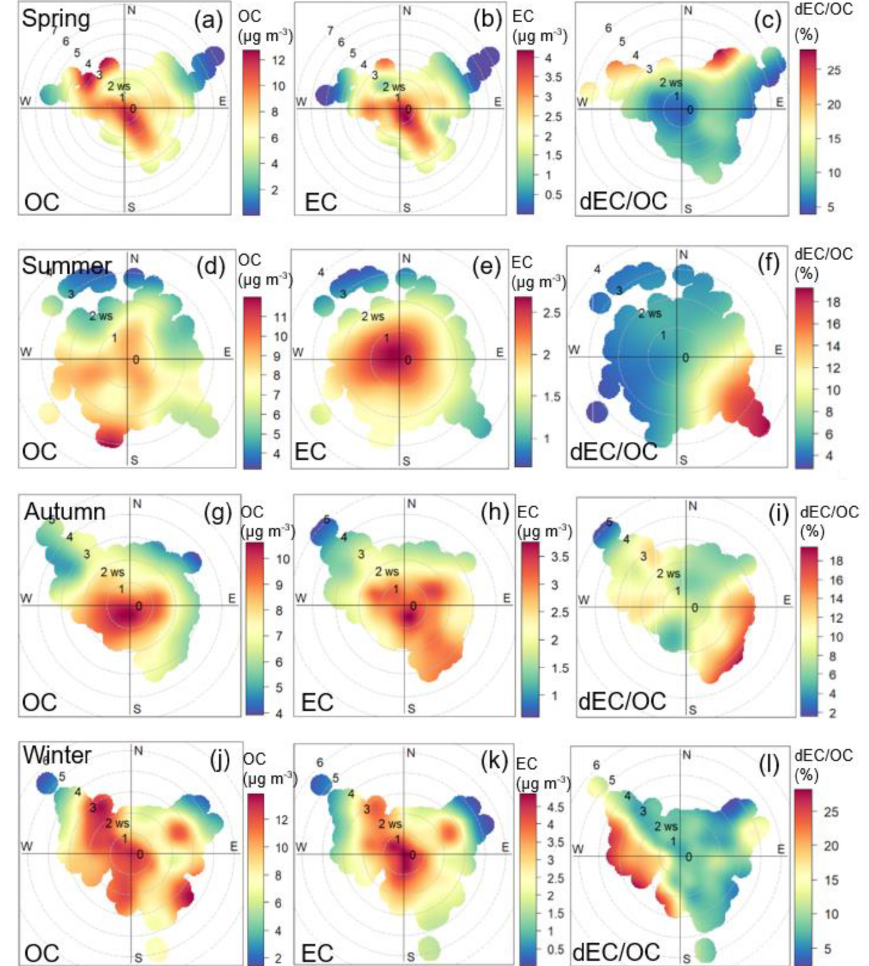
Figure 8. Wind rose of OC, EC and dEC / OC in spring (a–c) , summer (d–f) , autumn (g–i) and winter (j–l) .